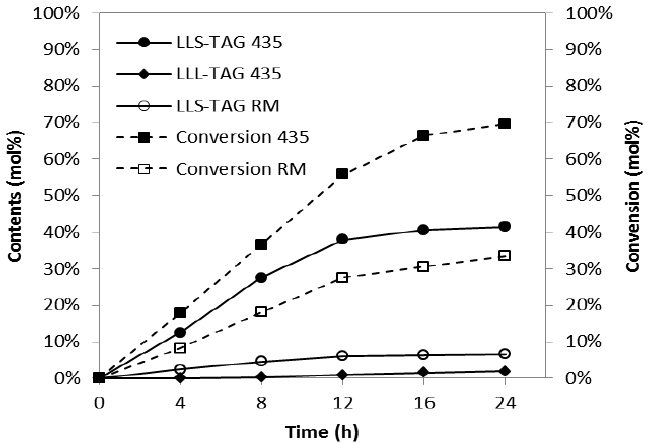
Figure 1. Efficiency of different lipases for the conversion of SLCTs at different time